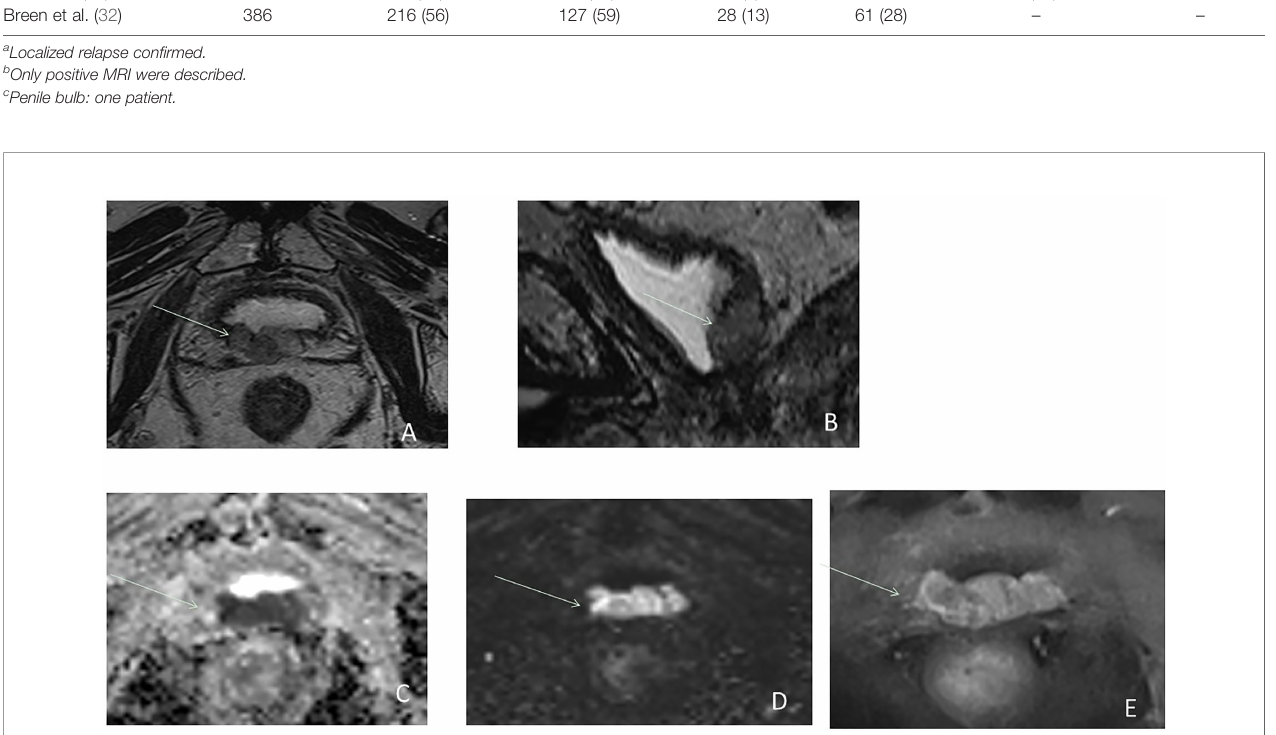
FIGURE 2 | Postsurgical lesion recurrence (arrow) in a 63-year-old male with serum PSA = 0.8 ng/ml. Axial T2W MRI (A) , sagittal T2W (B) , ADC map (C) , b2000 DW MRI (D) , and DCE MRI (E) show a large lobulated mass relatively hyperintense on T2W, hypointense area on the ADC map, hyperintense area on b2000, and with early hyperenhancement located in the postpart of the bladder